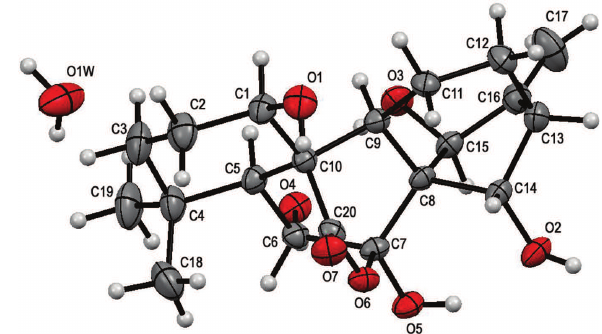
Table 1: Data collection and handling.